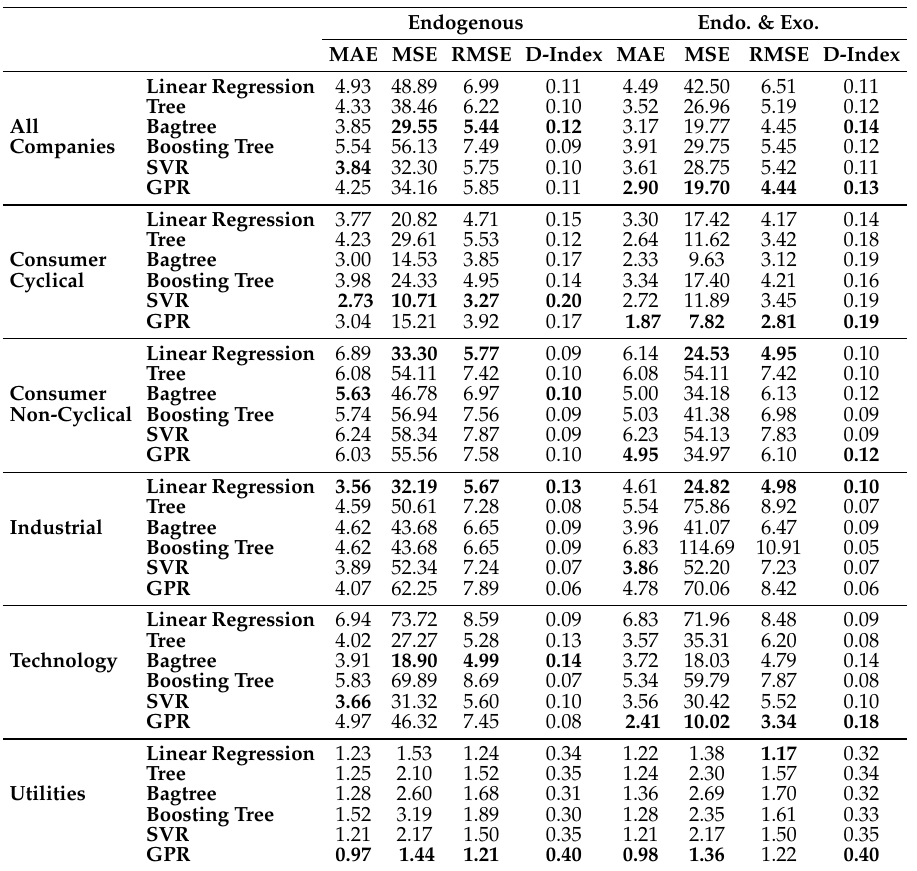
Table 1. Merit figures for the estimated EV models in different scenarios. By rows and grouped according to the companies, we include all the companies or group by sector. In columns, the merit figures for the evaluated scenarios incorporate only endogenous operational normalized variables, and both endogenous operational normalized and exogenous variables. The best method is painted in bold for each performance